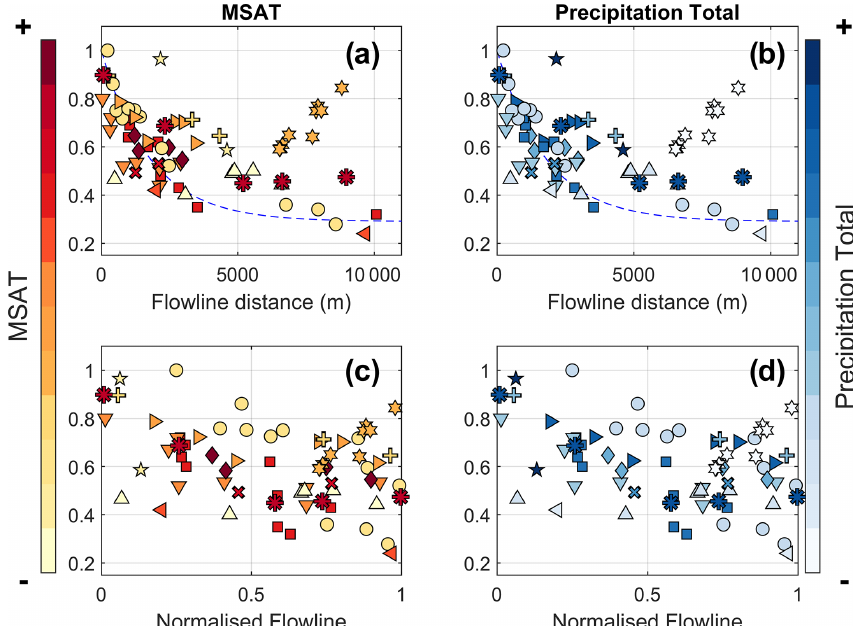
Figure 9. The k 2 sensitivities as a function of flowline distance (a, b) and a normalised distance, considering the total flowline distance for the year of study (c, d) . The individual glaciers of grouped studies (Parlung, CMBC and AVDM) are separated and normalised by the individual glacier length (symbols as in Fig. 8). Glaciers are coloured by rankings of the mean summer air temperatures (MSAT – a and c ) and precipitation total (b, d) . The original SM10 parameterisation is retained in (a) and (b) .